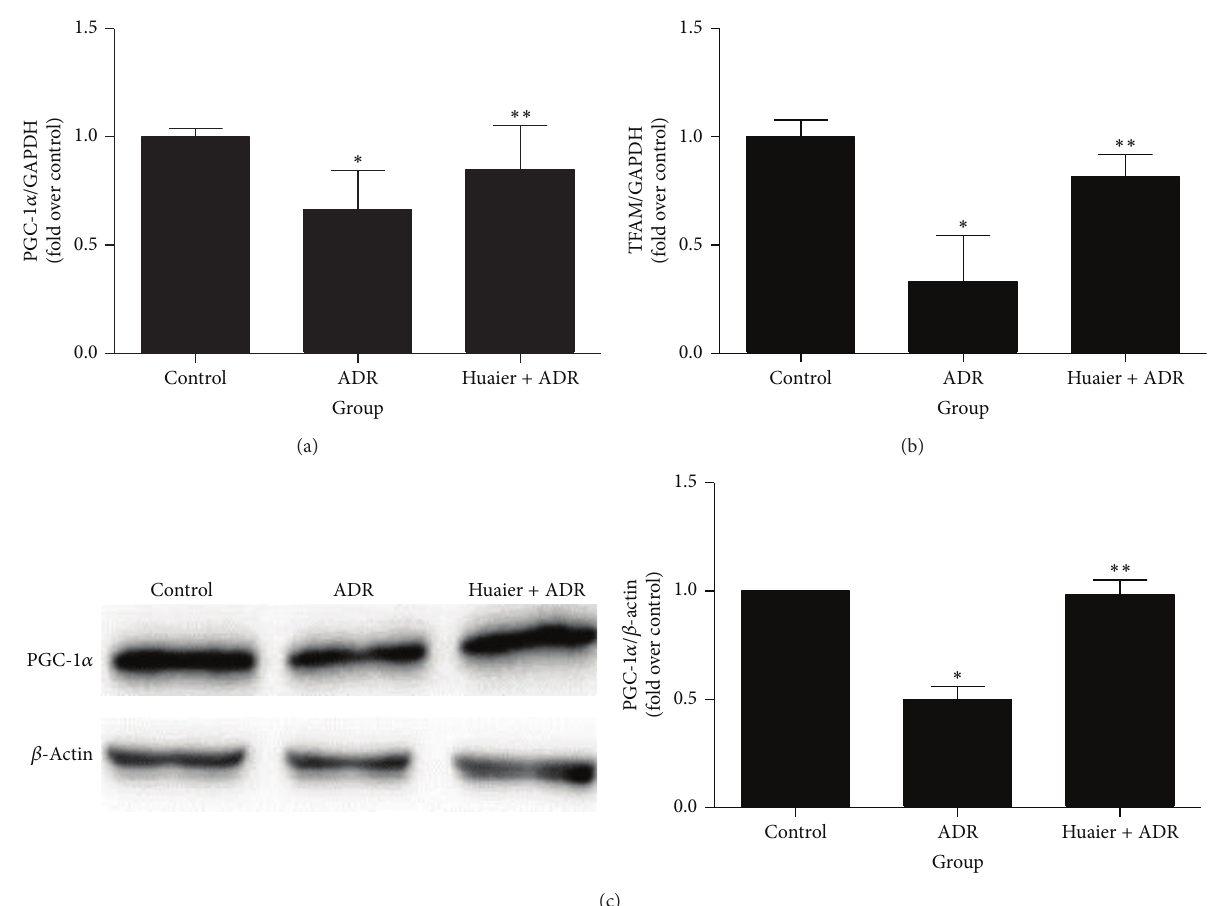
Figure 5: Huaier upregulated PGC-1 𝛼 in vivo . (a) Real-time RT-PCR of PGC-1 𝛼 . (b) Real-time RT-PCR of TFAM. (c) Western blot of PGC- 1 𝛼 . Left: representative immunoblots. Right: densitometric analysis. Data are expressed as the means ± SD ( 𝑛 = 6 ). ∗ 𝑃 < 0.05 versus control. ∗∗ 𝑃 < 0.05 versus ADR